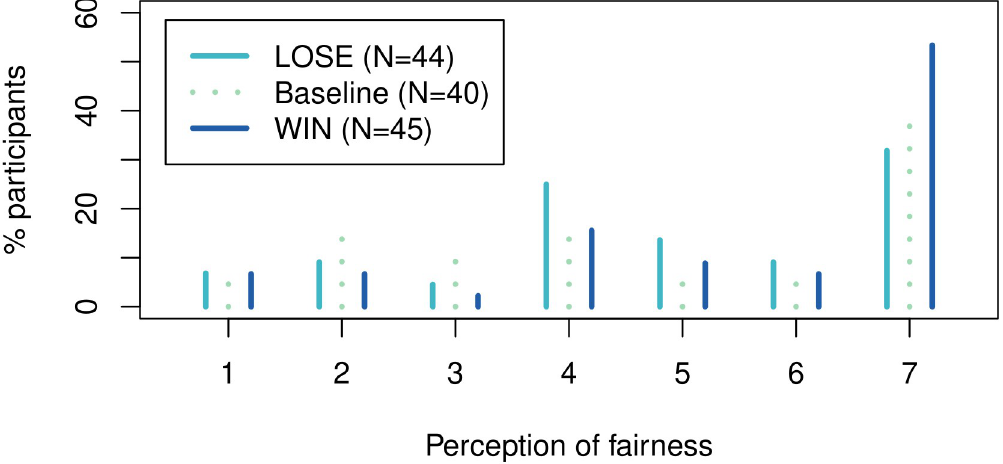
Fig 3. Perception of the fairness of the role allocation procedure by treatment condition. 1 implies an absolutely unfair procedure while 7 implies an absolutely fair procedure as far as the chances of both participants to determine the payoff